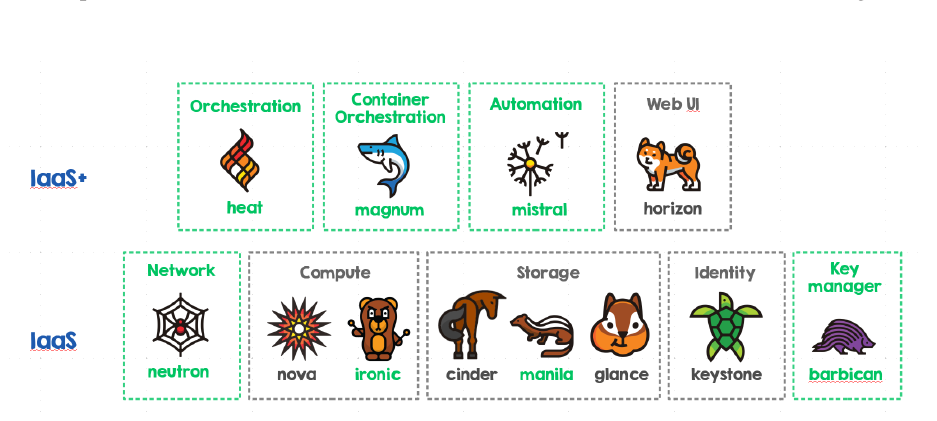
Figure 2. Initial service o ff ering